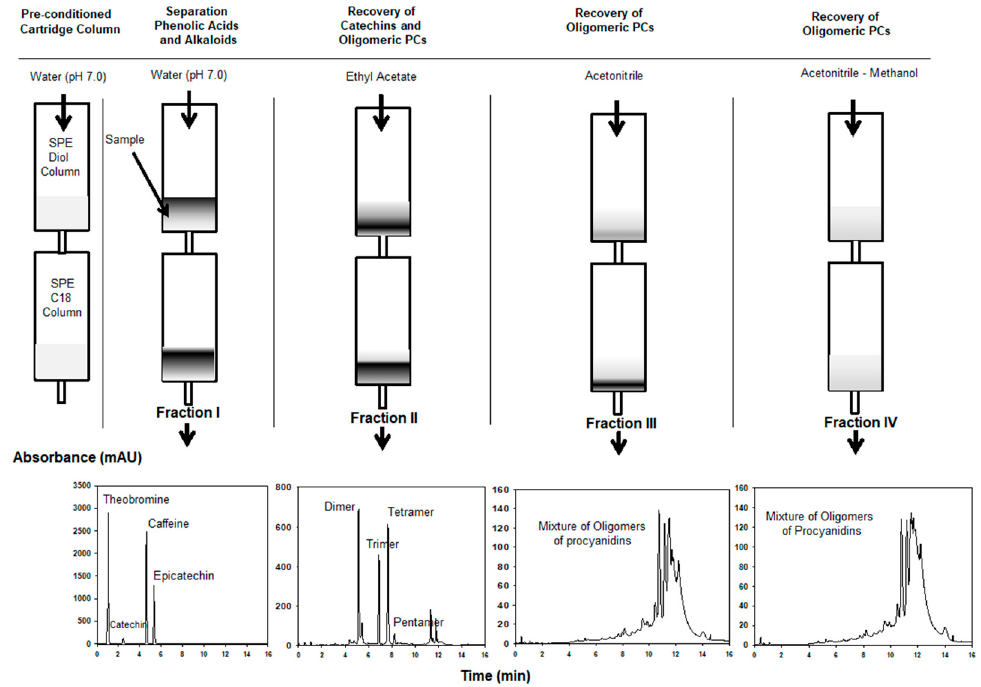
Figure 1. Scheme for the fractionation of procyanidins using SPE cartridges diol-C18 coupled in series.